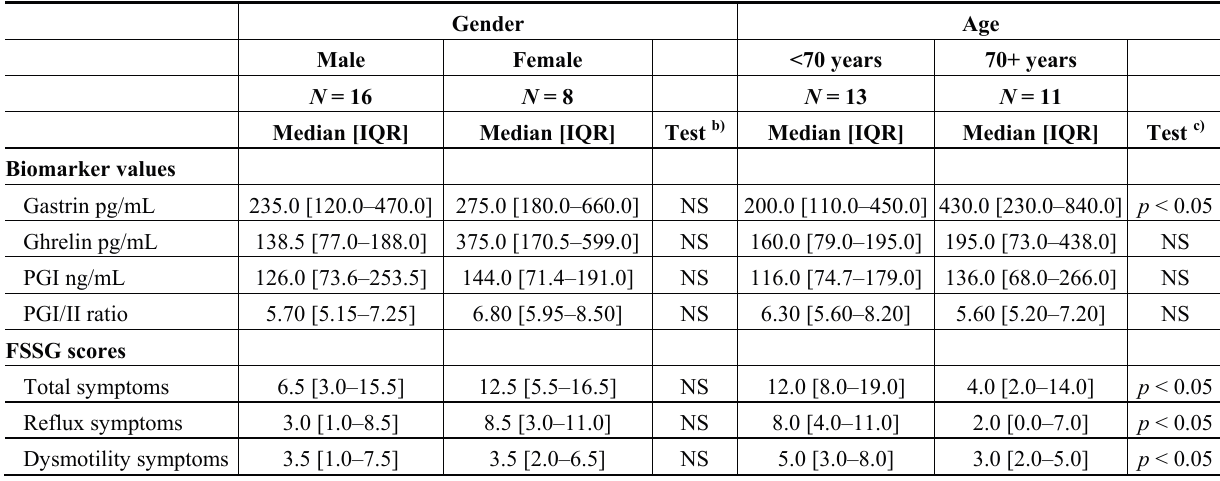
Table 1. Baseline relationship between the biomarker values and the FSSG symptom scores according to gender and age a)